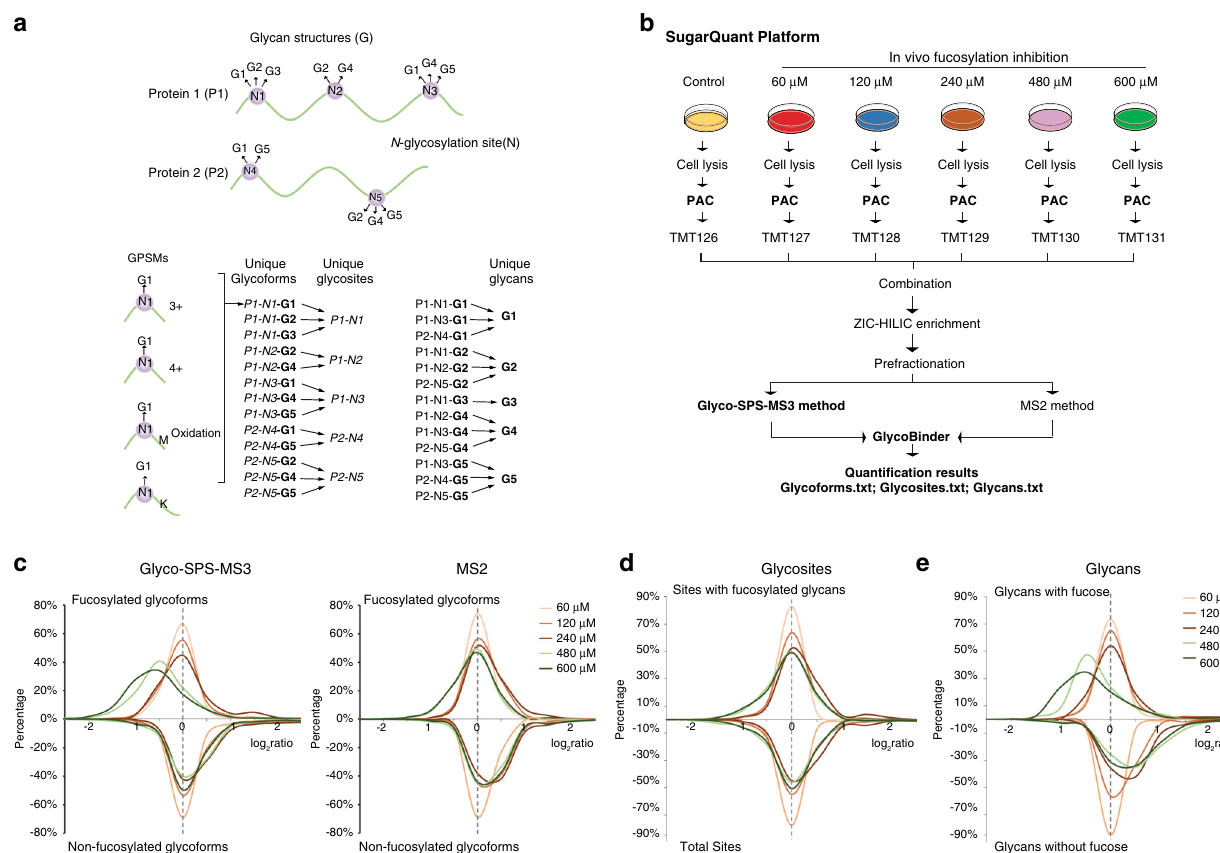
Fig. 4 Multi-dimension quantitative N -glycoproteomics of 2FF-treated human Burkitt ’ s lymphoma cells. a Schematic explanation of the propagation of quantitative information from GPSMs to unique glycoforms, glycosites, and glycans in this study. For one N -glycosylation site (N) on a protein (P), multiple glycans (G) may exist on the site, resulting in multiple glycoforms (represented as P-N-G). Quanti fi cation of unique glycoforms are achieved by summing TMT-reporter ion intensities of all involving GPSMs resulted from miscleavages, modi fi cations, and different charge states. Quanti fi ed glycoforms are further combined for glycosite (P-N) quanti fi cation. As for a unique glycan, the quanti fi cation values of all glycoforms with this particular glycan in the sample are combined. b The SugarQuant work fl ow conducted for the 2FF treatment on DG75 cells. n = 2 biologically independent cells. c Aligned ratio distributions of glycoforms quanti fi ed via the Glyco-SPS-MS3 (left) or the MS2 method (right) upon 2FF treatment. Different 2FF concentrations were color coded as shown in the fi gure. For direct comparison, we separate fucosylated glycoforms (upper panel) from non-fucosylated ones (lower panel). d , e Similar to b , but showing the 2FF-induced changes at the levels of glycosites (left) or glycan composition (right) determined by the Glyco-SPS-MS3. Source data are provided as a Source Data fi